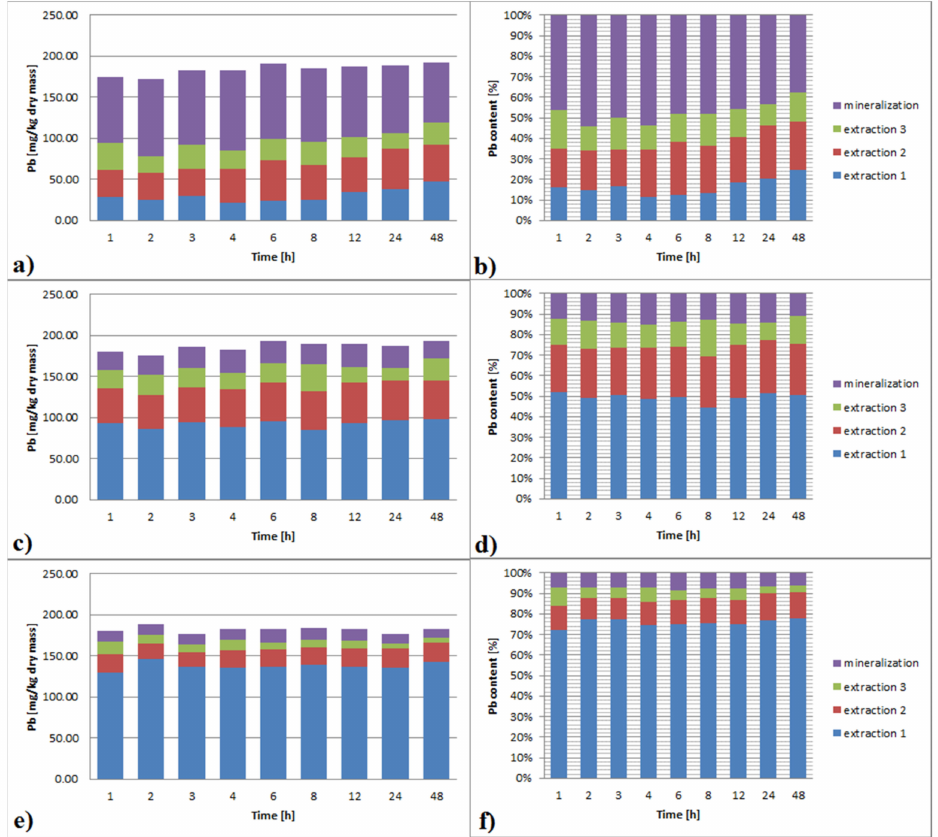
Figure 2. ( a – f ). Pb extraction from bottom sediments with different EDTA concentrations ( a , b ): 0.01 M; ( c , d ): 0.05 M; ( e , f ): 0.1 M and extraction